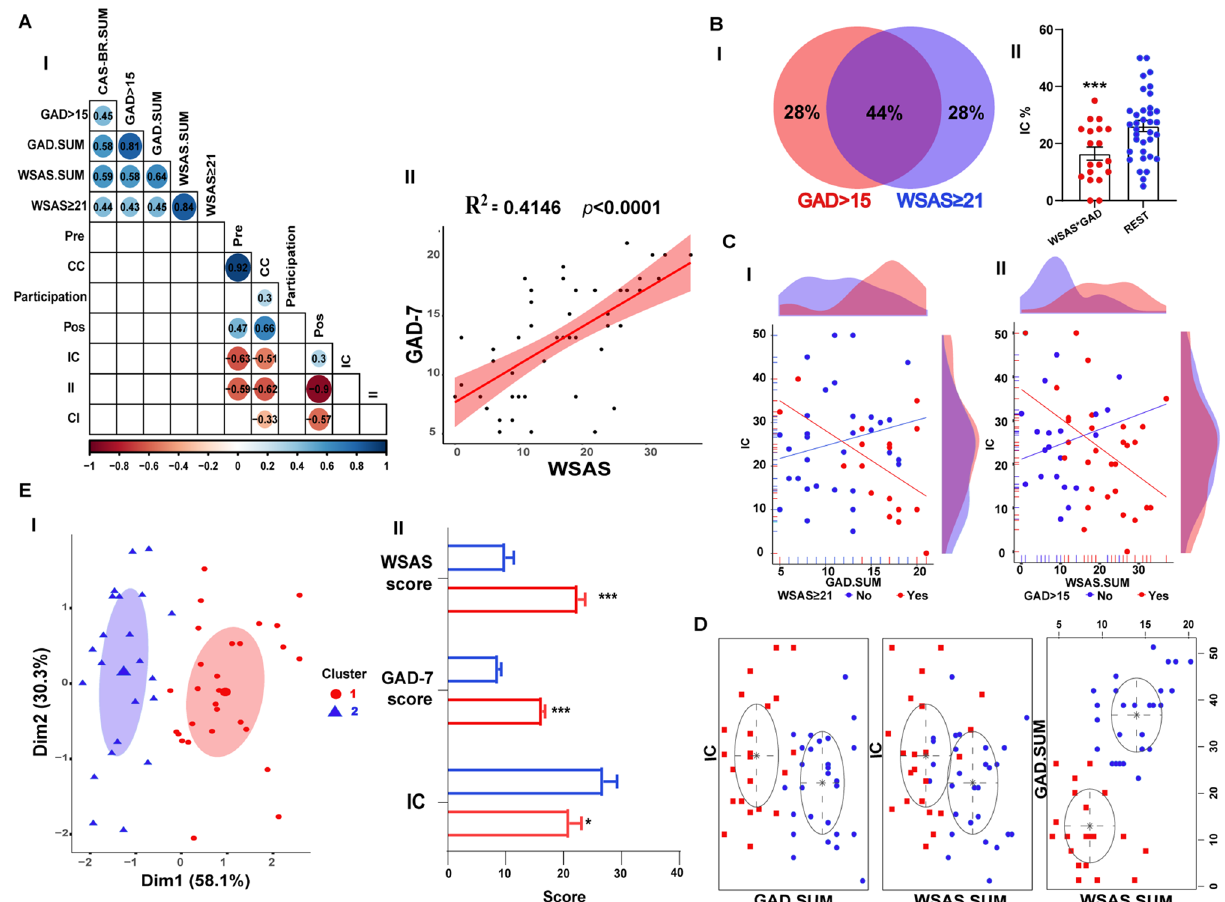
Figure 3 . Data modeling indicates that high levels of anxiety and dysfunctionality negatively impact students’ learning performance. (A-I) Correlation matrix of (i) the scores in the psychological tests (GAD.SUM, WSAS. SUM, GAD.15, WSAS.21, and CASBR), (ii) answer categories (CC, IC, CI, and II), (iii) the proportion of answers in the pre and post-test (Pre and Pos), and (iv) Sex. (II) Positive correlation between GAD-7 and WSAS. (B-I) The Venn Diagram represents the intersection between individuals with scores higher than 15 in GAD-7 and greater than or equal 21 in the WSAS test. (II) Comparison between the individuals with higher scores of GAD-7 and WSAS and the percentage of IC category. (C-I) A Bimodal distribution is observed by analyzing the GAD-7 score by cut-off from WSAS ( ≥ 21) and (II) the WSAS score by cut-off from GAD (> 15). (D) The Gaussian mixture model indicates that data comes from two Gaussian diagonal distributions. (E-I) Representation of GAD, IC, and WSAS distribution values in the two theoretical clusters, and (II) the different profiles of psychological status and learning process in clusters 1 and 2. To indicate no significative differences between the groups we use ‘n.s.’, and the significant differences were listed as *p < 0.01, **p < 0.001, and ***p < 0.0001. Answers to pairs of multiple-choice questions are indicated as correct–correct (CC), incorrect– correct (IC), correct–incorrect (CI), and incorrect–incorrect. GAD-7 generalized anxiety disorder scale, WSAS Work and social adjustment